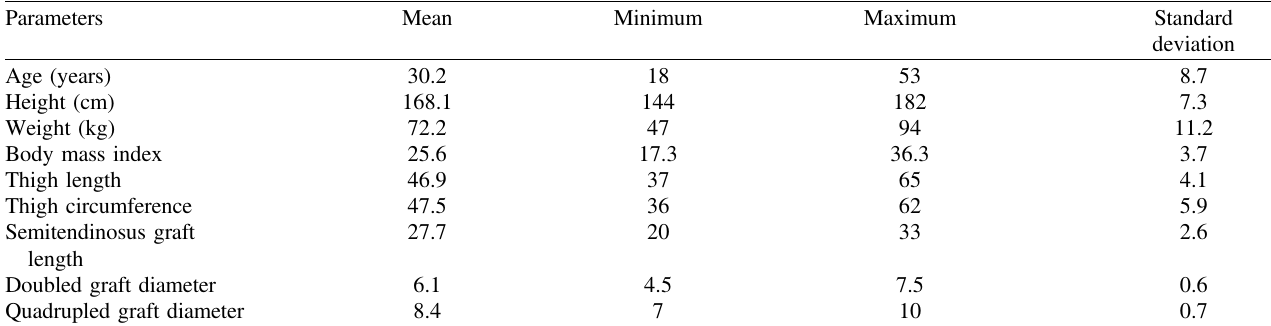
Table 1. Demographic and anthropometric details of patients.